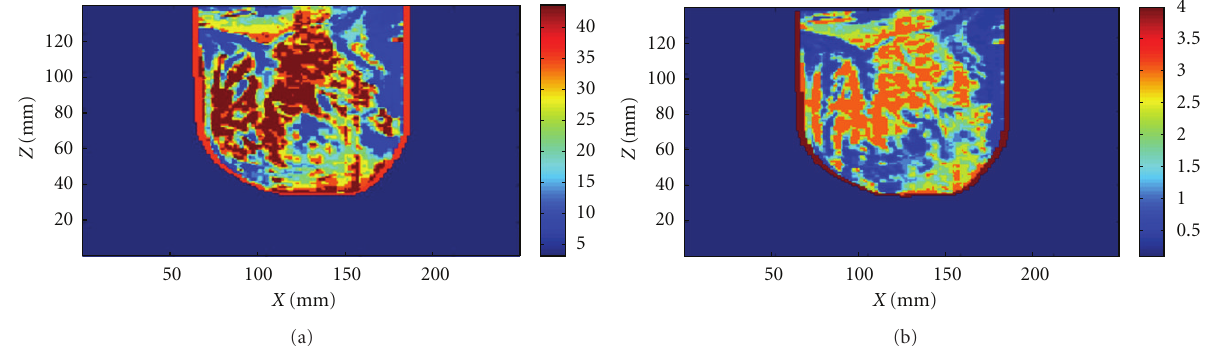
Figure 16: Permittivity (a) and conductivity (b) distribution in cross-section of a simulated breast model after adjustment for floatation in